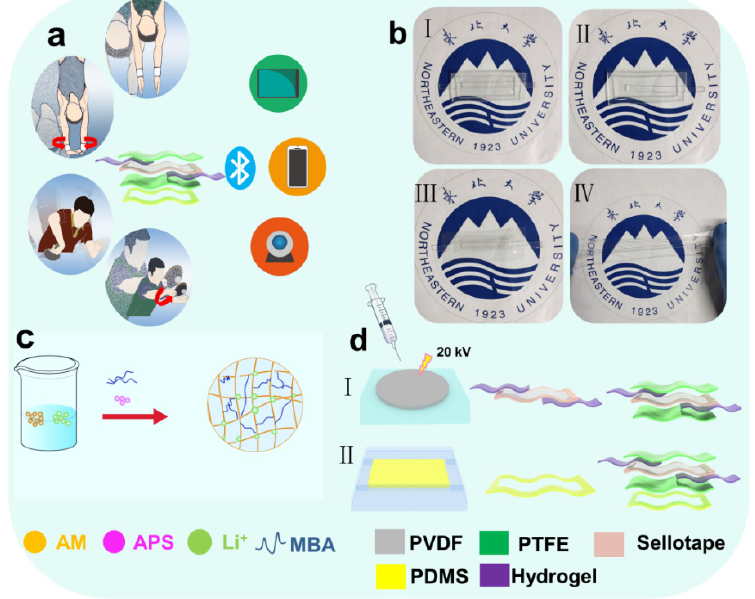
Figure 1. The drawing of the PTSS and its applications. ( a ) Scene of how the PTSS is used for sports. ( b ) Optical image of the PTSS ( I ), TENG ( II ), PENG ( III ), and hydrogel ( IV ). ( c ) Manufacturing step of the hydrogel. ( d ) Manufacturing step of the PVDF film and PDMS substrate and schematic diagram of the PTSS combination.